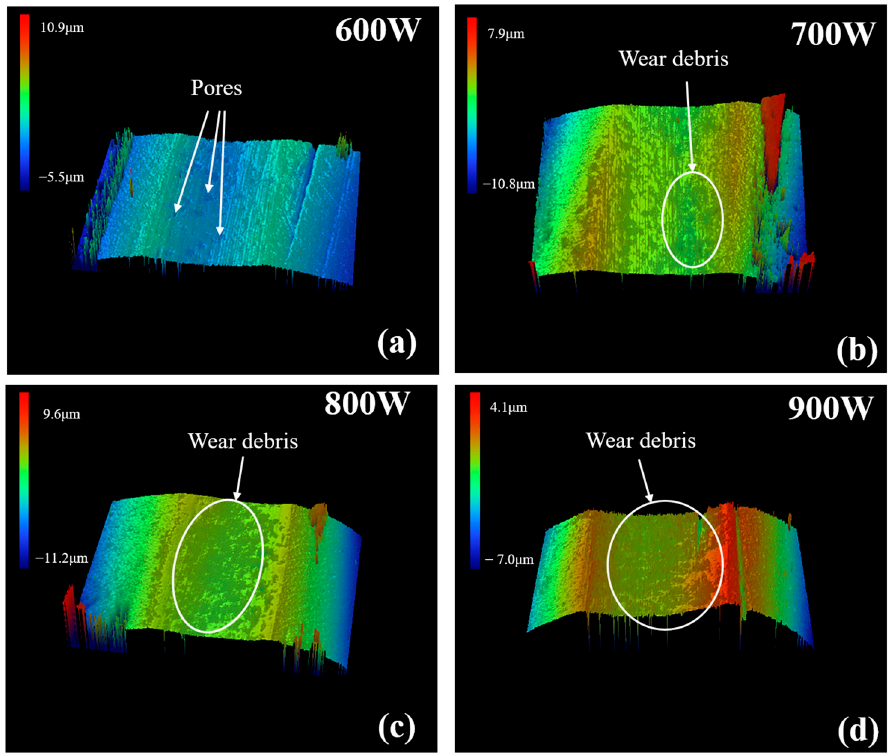
Figure 18. The 3D wear morphologies of coatings under different ultrasonic power: ( a ) 600 W; ( b ) 700 W; ( c ) 800 W; ( d ) 900 W.